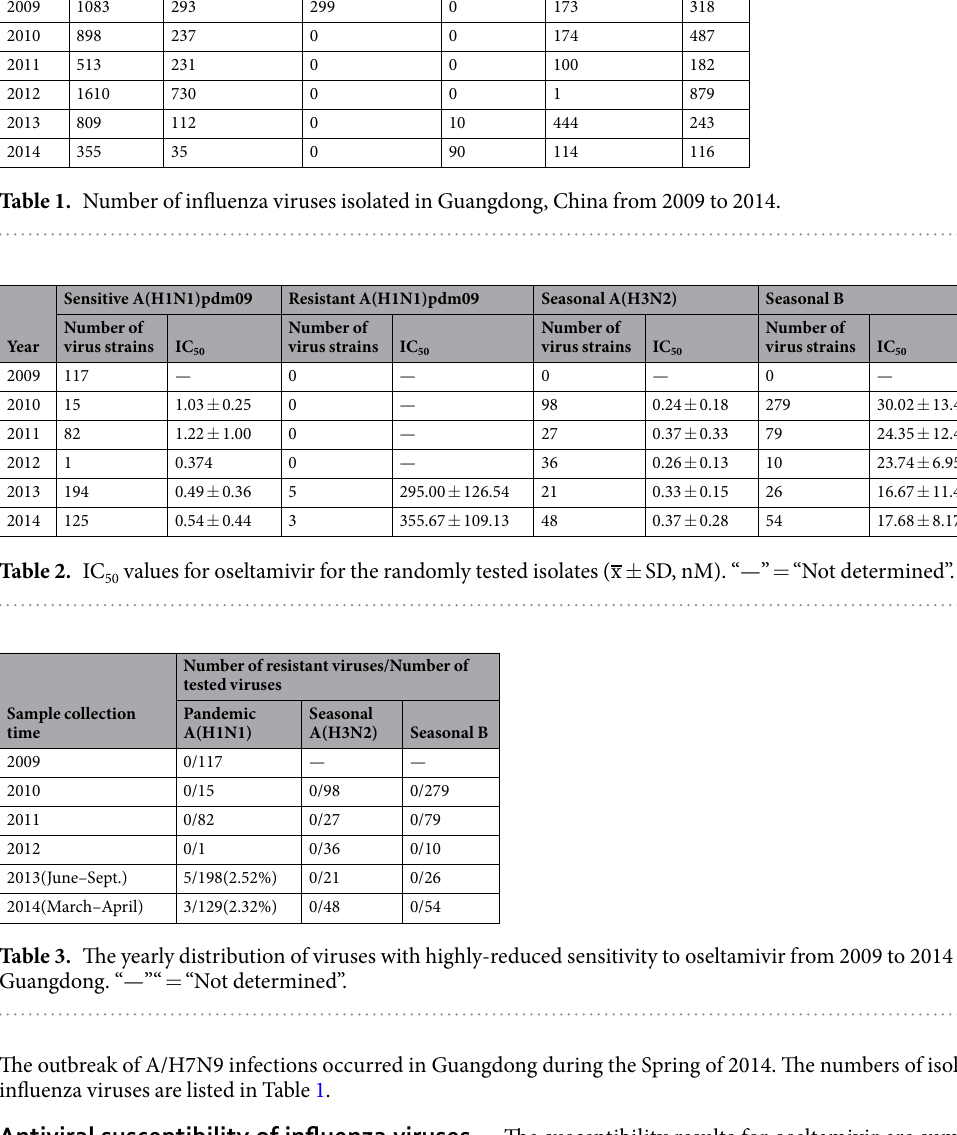
Analysis of the genetic characteristics of NA.